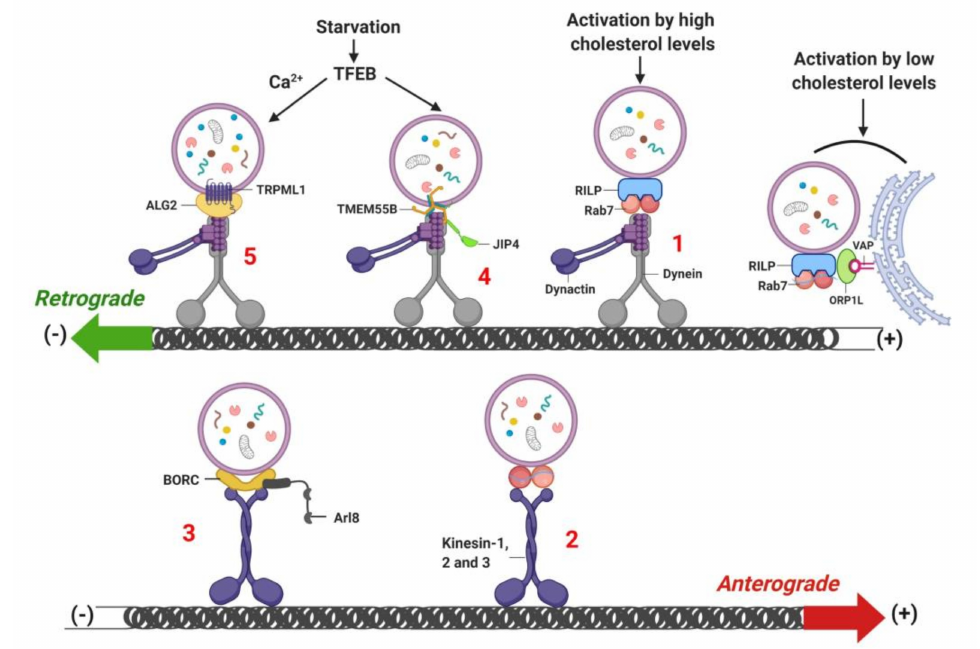
Figure 6. Retrograde- and anterograde-dependent lysosome mobilization. Lysosomes move from the cell periphery towards the perinuclear region in a retrograde manner. (1) The retrograde movement of the lysosome is initiated by RILP-Rab7-dependent recruitment and activation of dynein-dynactin, enabling the transport of lysosomes to minus-end direction. (2) While anterograde movement transport lysosomes from the perinuclear to the cell periphery, which requires kinesin-1, 2 and 3 motor proteins. (3) Anterograde movement of lysosomes also requires BLOC-1-related complex (BORC)-dependent recruitment of Arl8, which activates the kinesin proteins. (4) and (5) starvation-induced activation of TFEB increases the transcription of TRPML1 and TMEM55B to trigger lysosome mobilization in a retrograde manner via interaction with ALG2 (an EF-hand-containing protein, serve as lysosomal Ca 2 + sensor) and JIP4 (C-Jun-amino-terminal kinase-interacting protein 4), respectively. Low cellular cholesterol levels restrict lysosomes at the plus end, which is mediated by the interaction between lysosomal RILP and Rab7 with VAP and ORP1L on ER